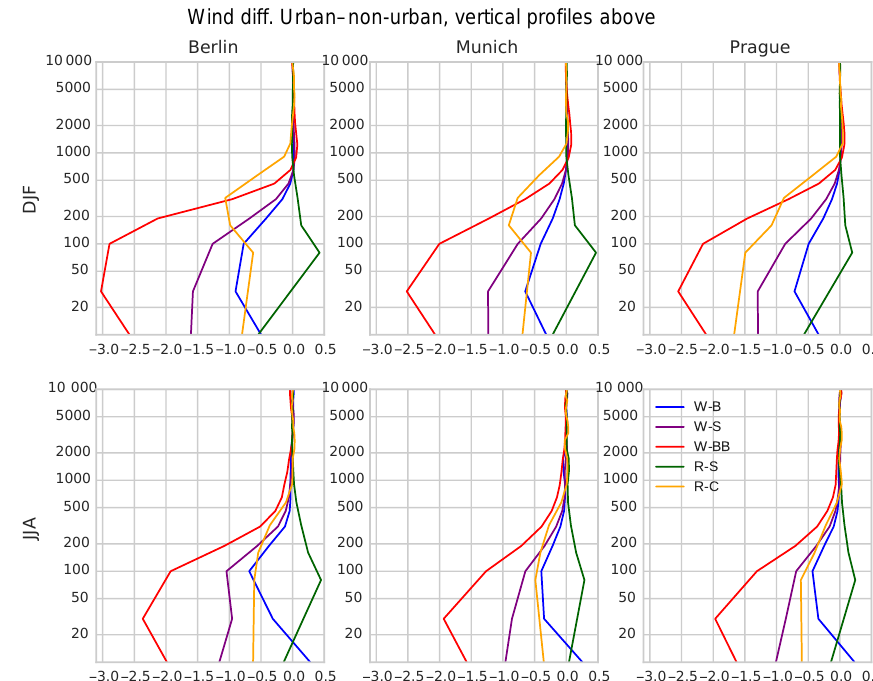
Figure 13. The impact of the urban surface inclusion on the wind speed vertical profile (ms − 1 ) over selected cities. The y axis indicates the altitude in